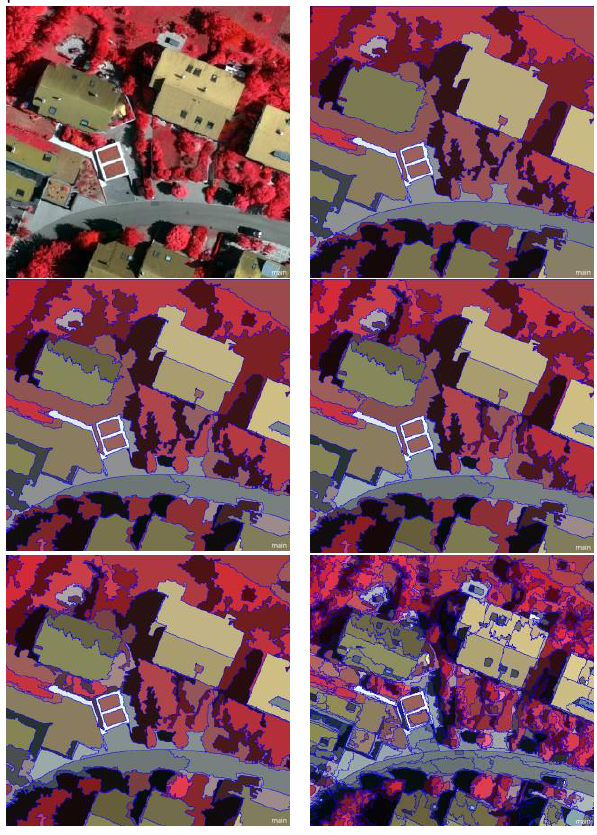
Table 1. Mean object size and estimated scale parameter to